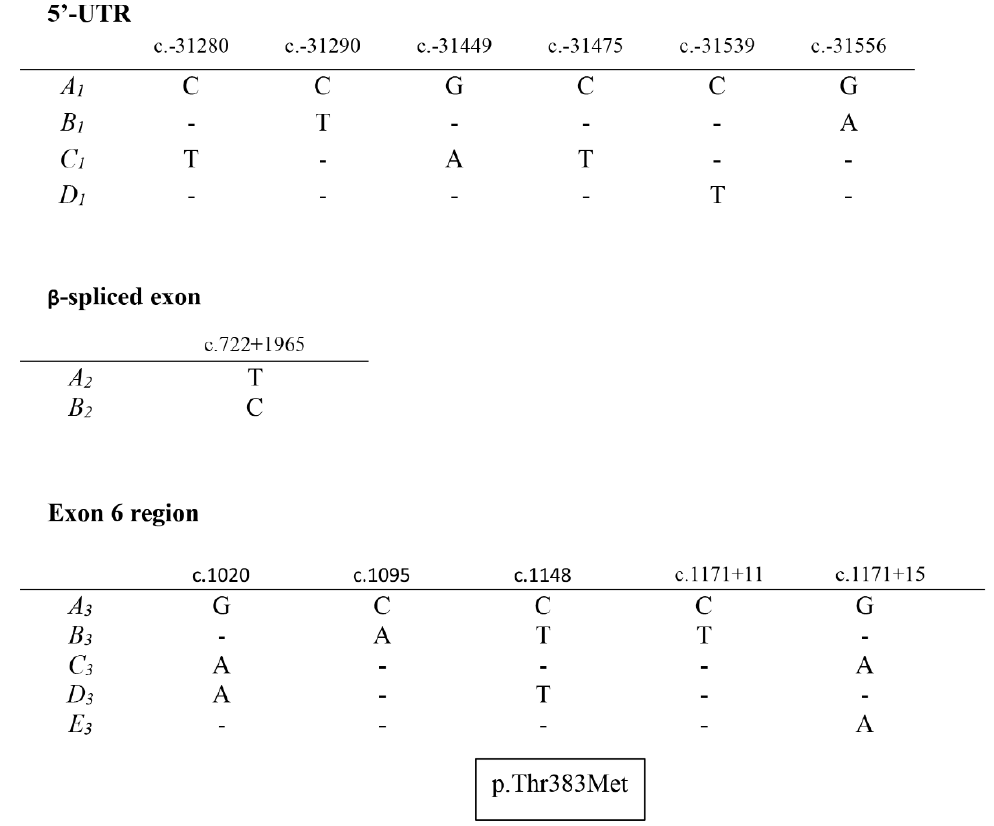
Figure 1. Sequence variation in the ovine lipin 1 gene ( LPIN1) identified by polymerase chain reaction- single strand conformation polymorphism (PCR-SSCP) analysis. Different SSCP banding patterns for amplicons from the three gene regions are shown in either homozygous or heterozygous forms. “E” indicates a coding exon, and “β-spliced” indicates the alternatively spliced exon used in LPIN1β .